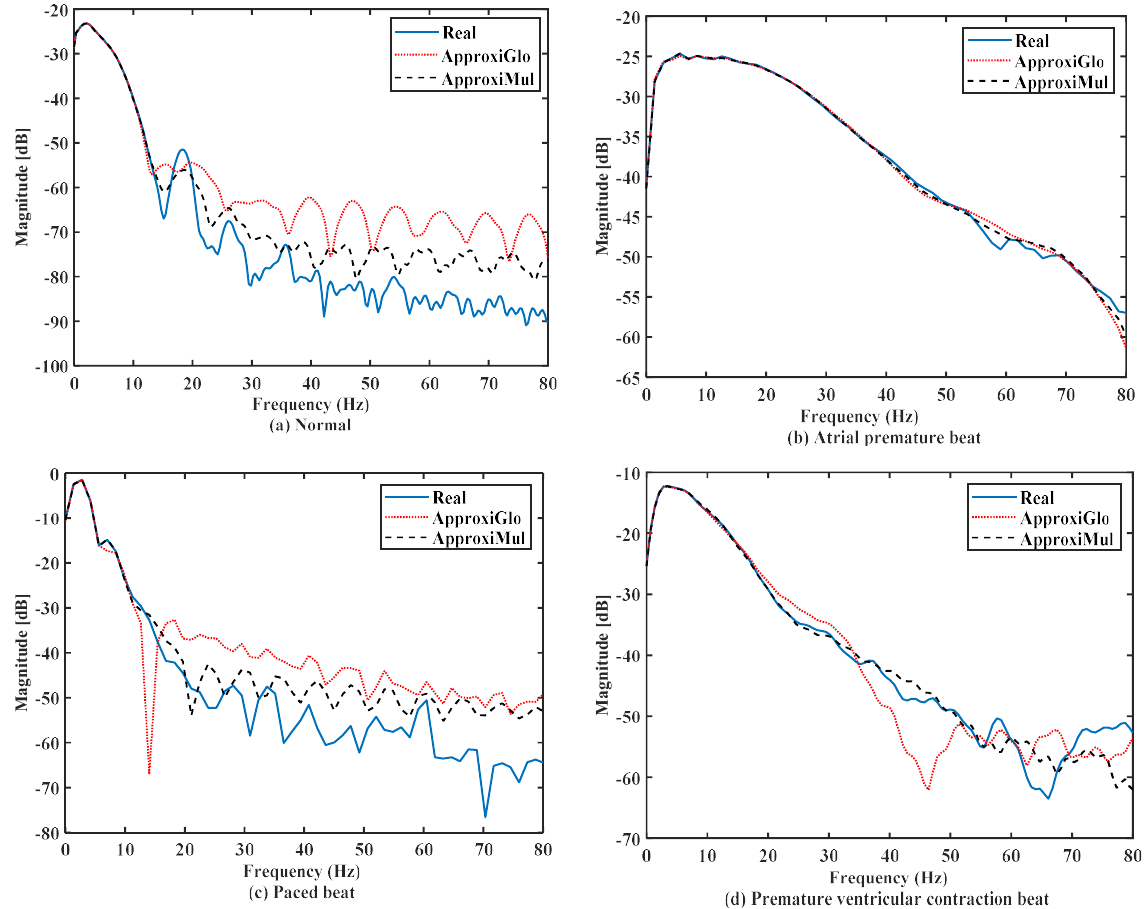
Figure 8. PSD of different types of ECG beats representing physiological or pathophysiological